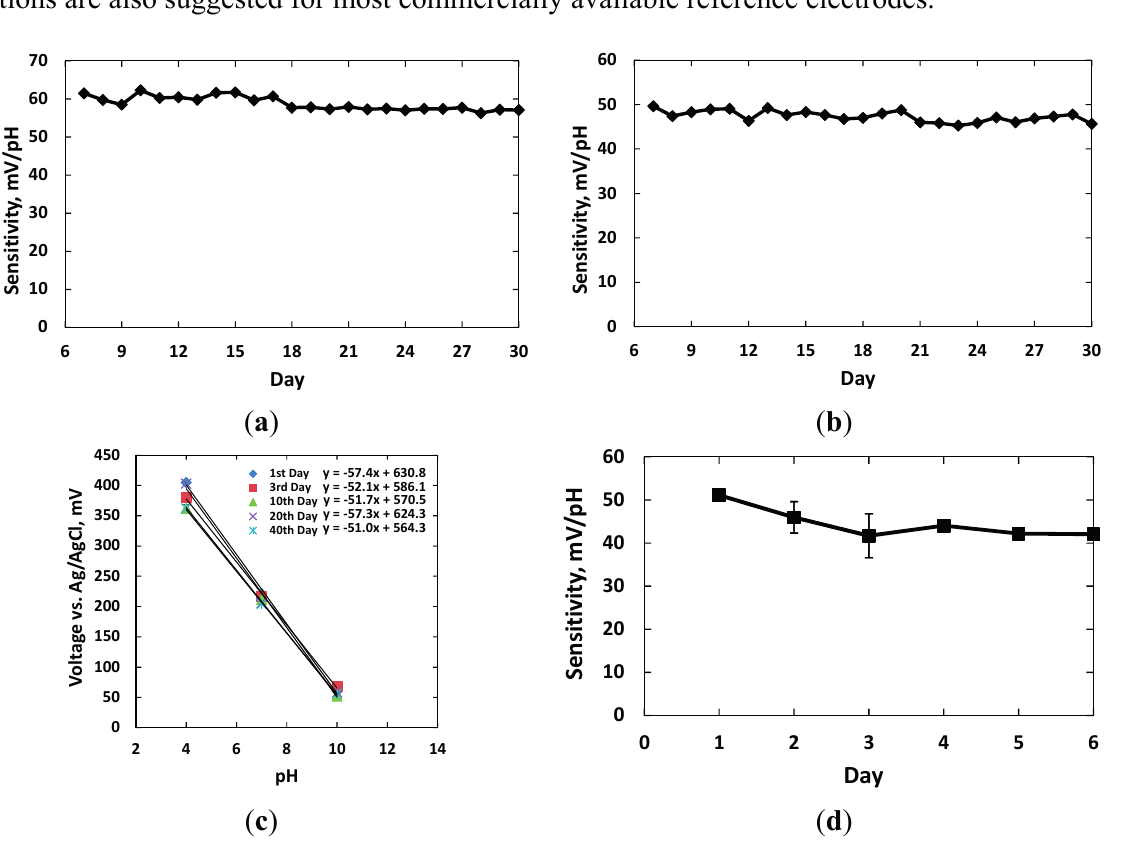
Figure 6. Longevity of IrO x -based electrodes was examined by soaking the electrodes in different solutions for a period of time, and keeping in dry condition. Twelve electrodes were classified into four groups. The sensor sensitivities of each group kept in: ( a ) hydrochloric acid solution (pH = 2) for 30 days; ( b ) alkaline solution (pH = 10) containing high concentration of sodium and potassium ions for 30 days; ( c ) standard tissue culture media supplemented with 10% FBS for 40 days; ( d ) dry condition for 6 days, after fabrication were